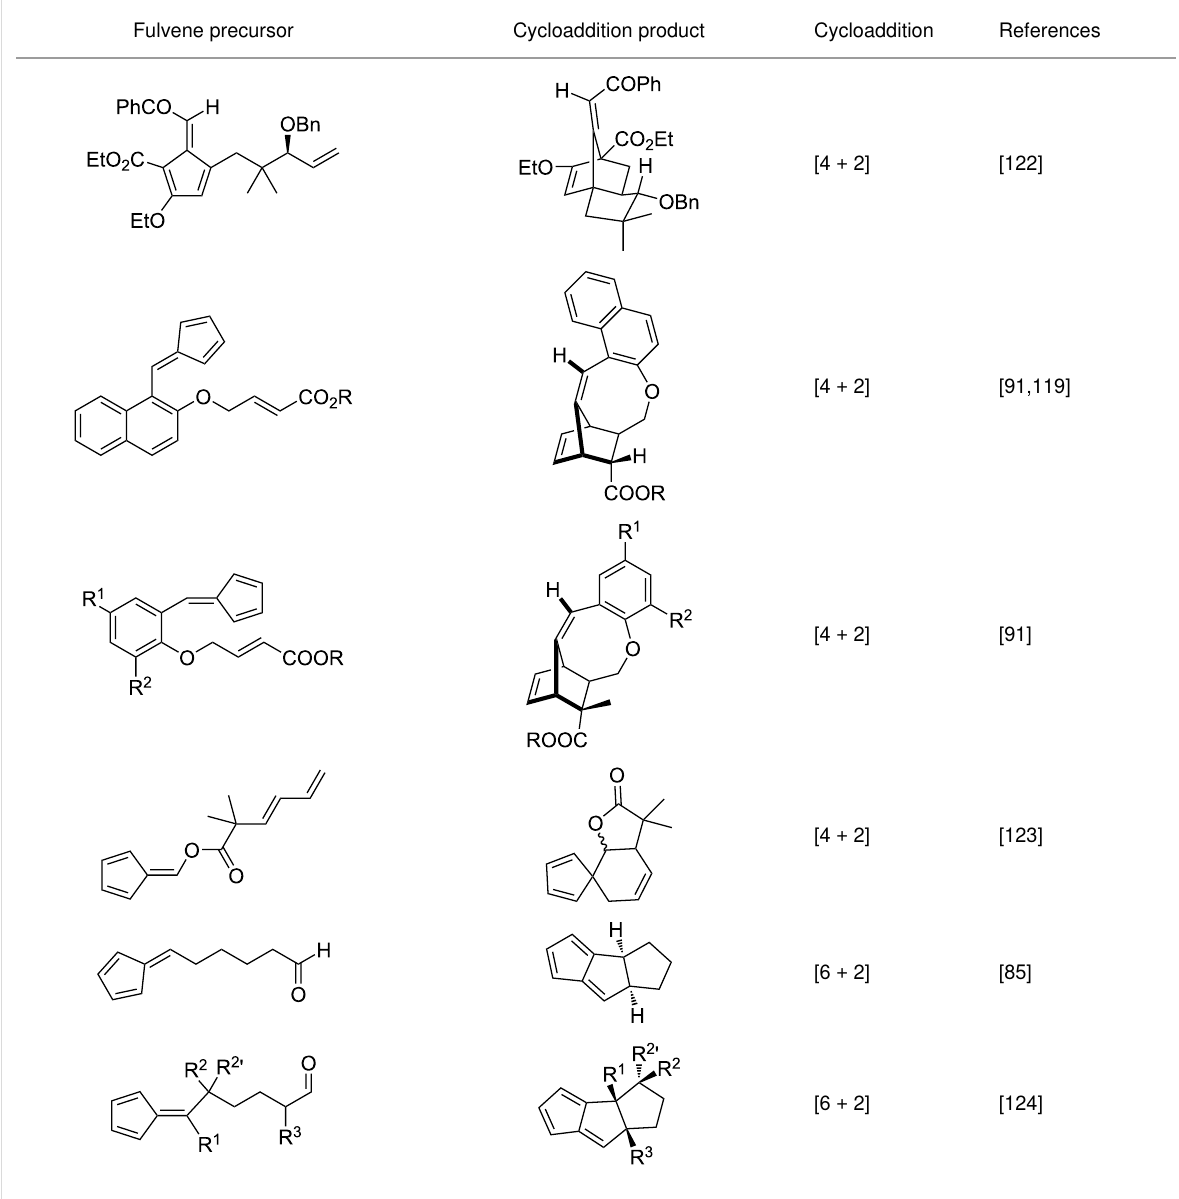
Table 1: Structures and cycloaddition notation of fulvene intramolecular